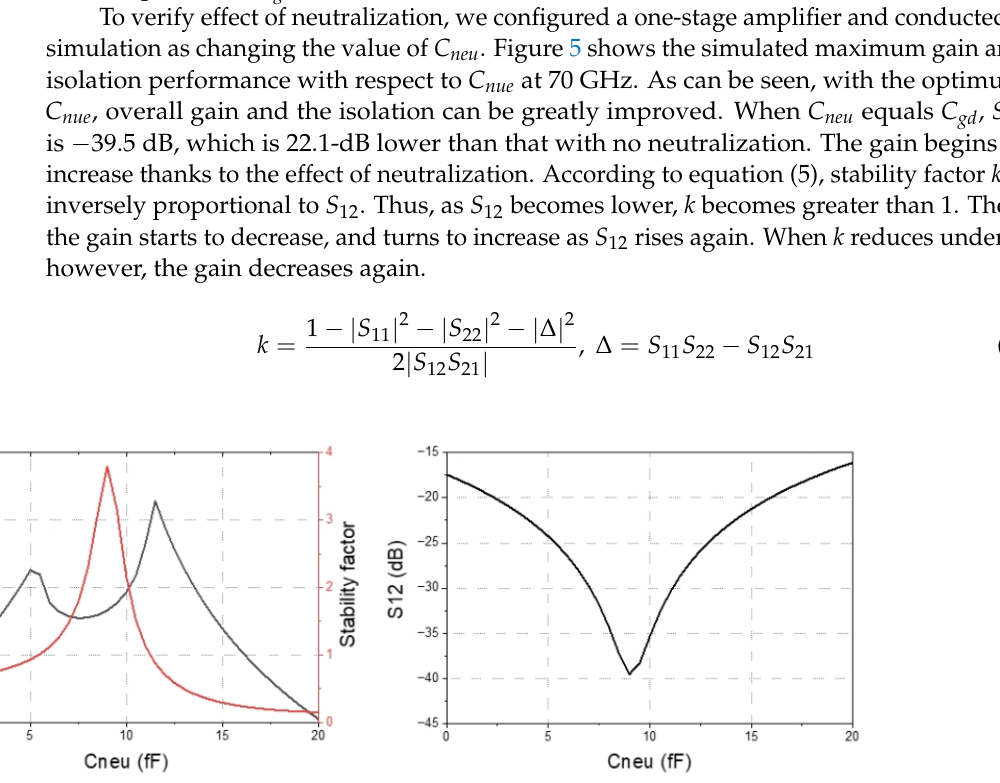
Figure 4. Small signal equivalent circuit with capacitive neutralization.